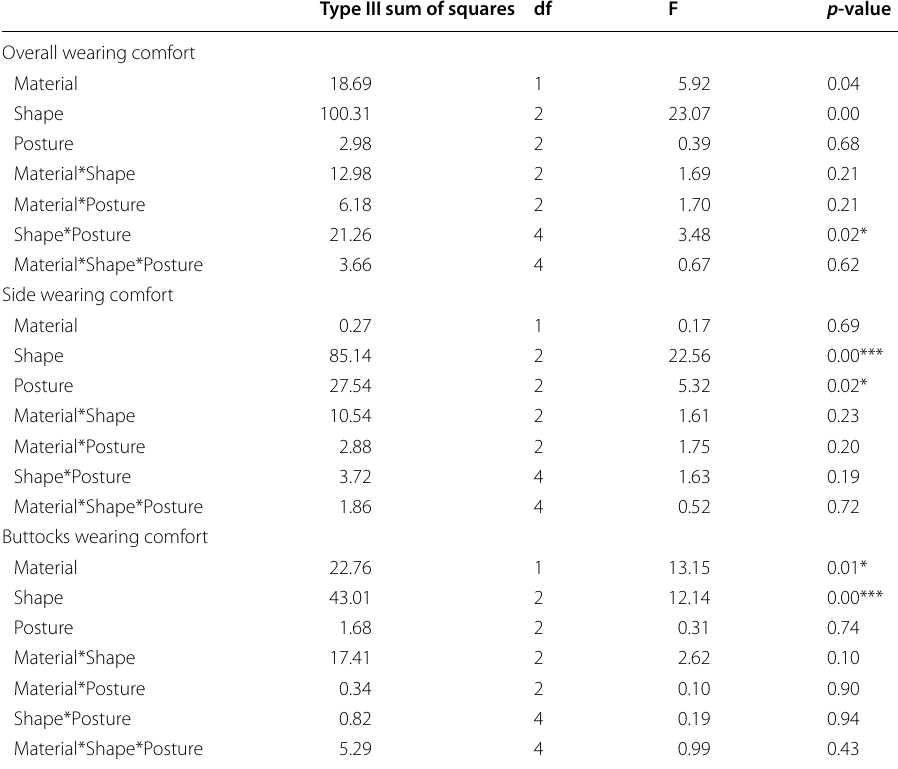
Table 2 Subjective comfort depending on material, shape, and test posture (repeated measures